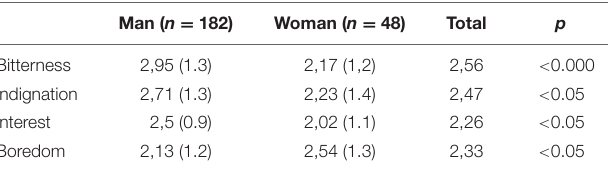
TABLE 5 | Descriptive statistics of emotions ∗ Parodied politician’s gender (mean and SD).